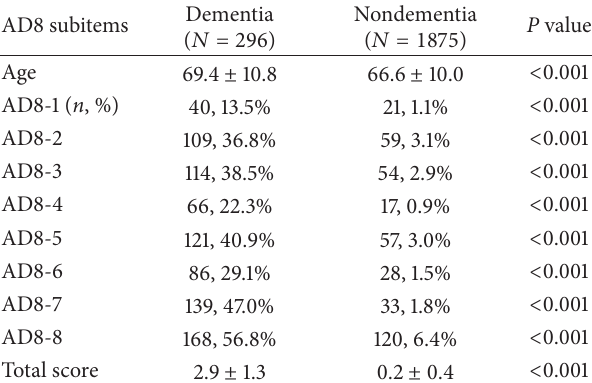
Table 3: AD8 subitems in dementia and nondementia